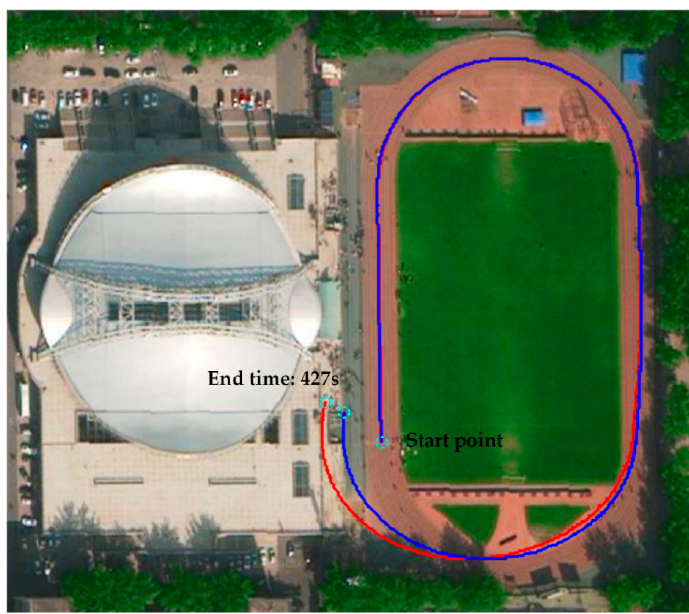
Figure 16. Results of walking around the playground in a circle. The red line represents the pedestrian trajectory calculated by the ZUPT-aided pedestrian navigation algorithm with the fixed threshold method; the blue line is the pedestrian trajectory calculated by the ZUPT-aided pedestrian navigation algorithm with the adaptive ZVI detection algorithm.